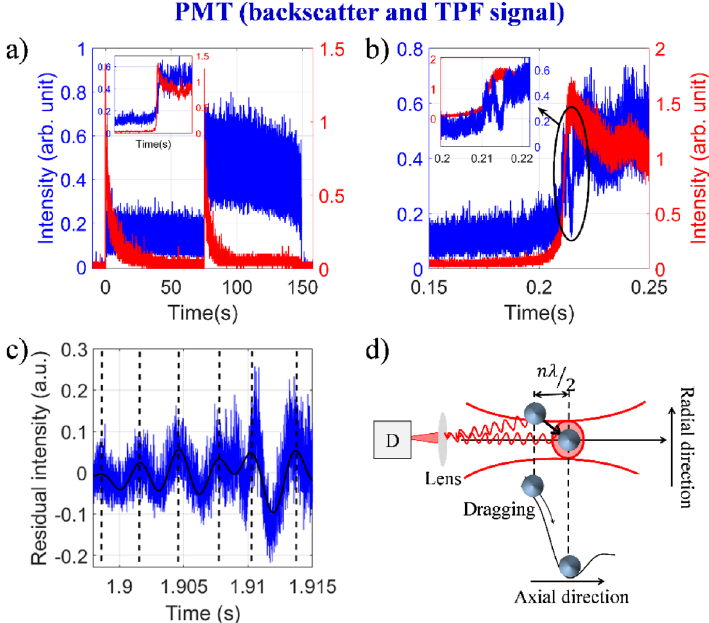
Figure 4. Backscatter and TPF signal ( a ) when two particles confined within the trap and data collection interval is 400 μs; zoomed plot shows the drag of second particle, ( b ) drag of second particle and data collection interval is 400 ns, and ( c ) residual intensity of backscatter signal fitted with Fourier function (black dotted lines represent the peak-to-peak time) at 18.80 mW average power under pulsed excitation. Color: black curve corresponds to Fourier series fitting, red and blue curves correspond to TPF and backscatter signals, respectively. ( d ) Schematic depicting origin of interference pattern during dragging of the second particle when the first particle resides within the nonlinear optical